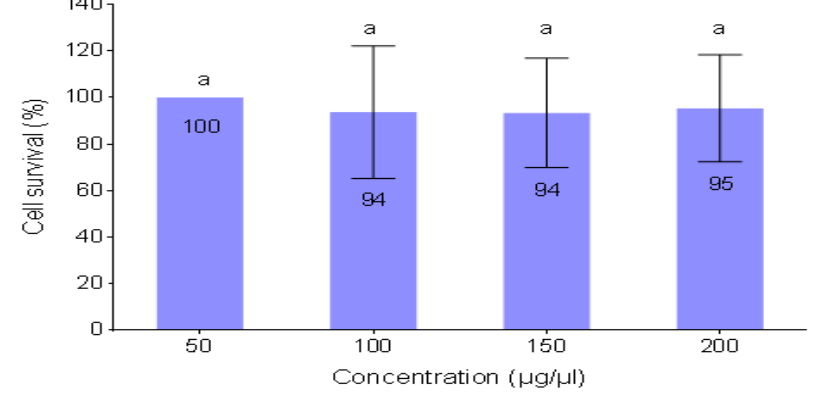
Figure 10. In-vitro cytotoxicity of di ff erent concentrations of bioflocculant on HEK293 di ff erent letters (a) denotes statistical significance at ( p < 0.05).